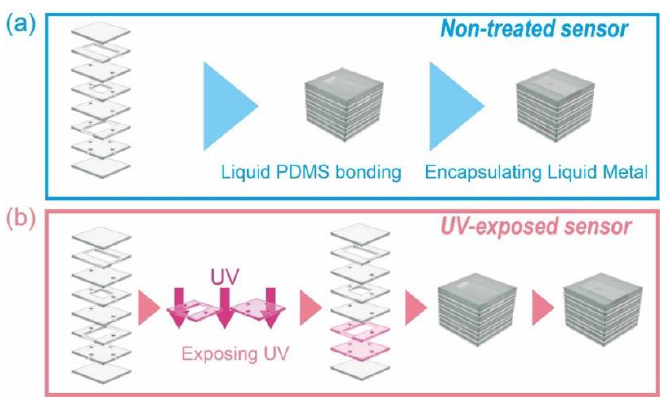
Figure 4. Fabrication process of ( a ) nontreated sensor and ( b ) UV-exposed sensor.